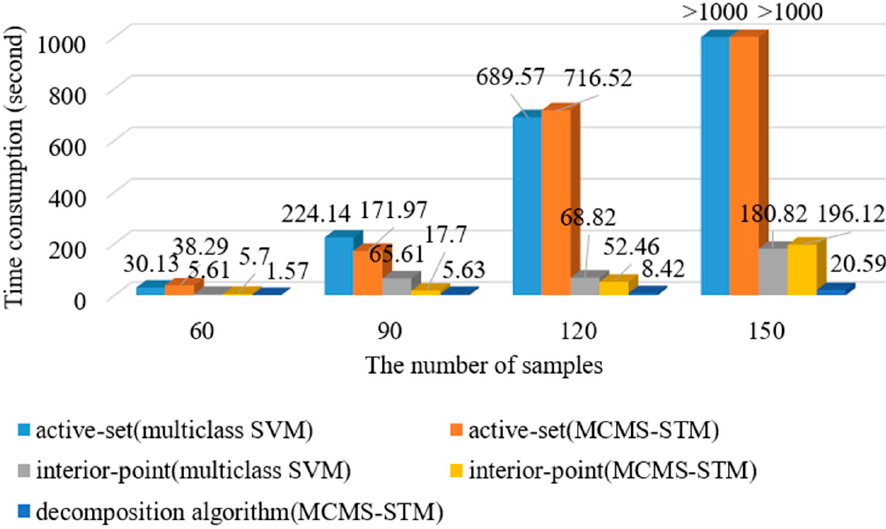
Figure 10. The time consumption of solving the dual problem of MCMS-STM and multiclass SVM using different optimization solving algorithms under different numbers of training samples.